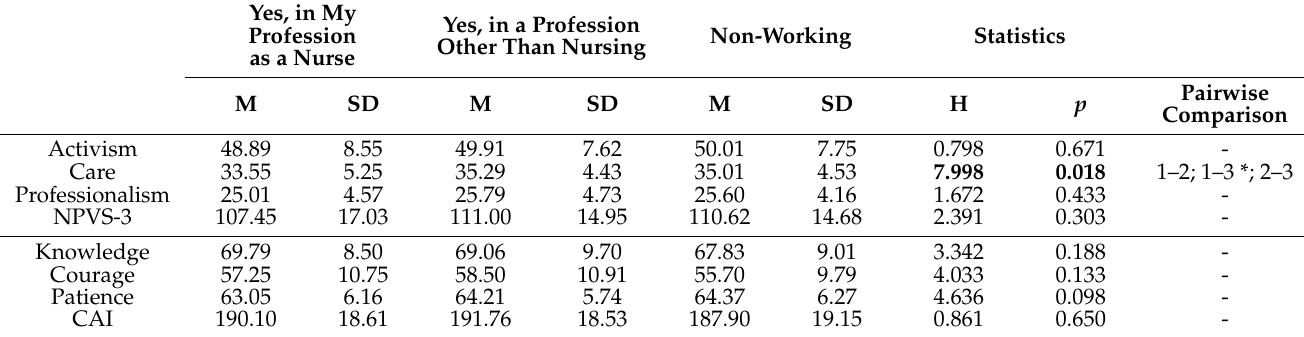
Table 7. Correlation between work and NPVS-3 and